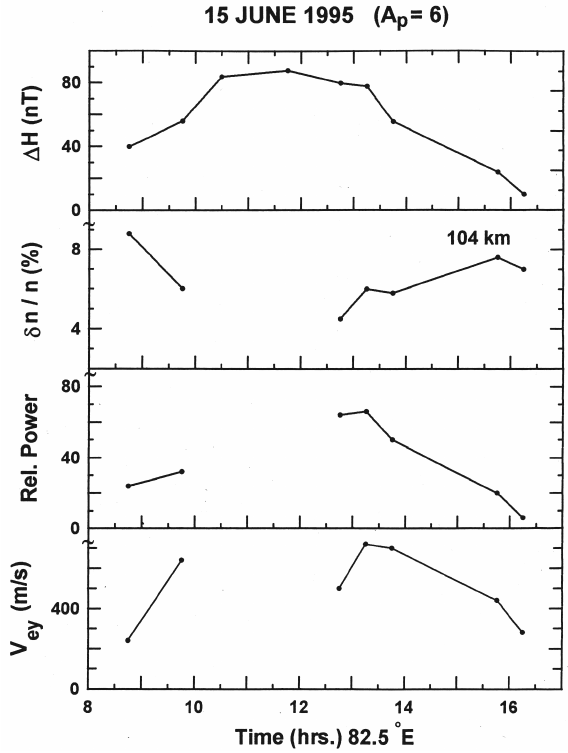
Fig. 8. Same as Fig. 5, but for 15 June 1995.